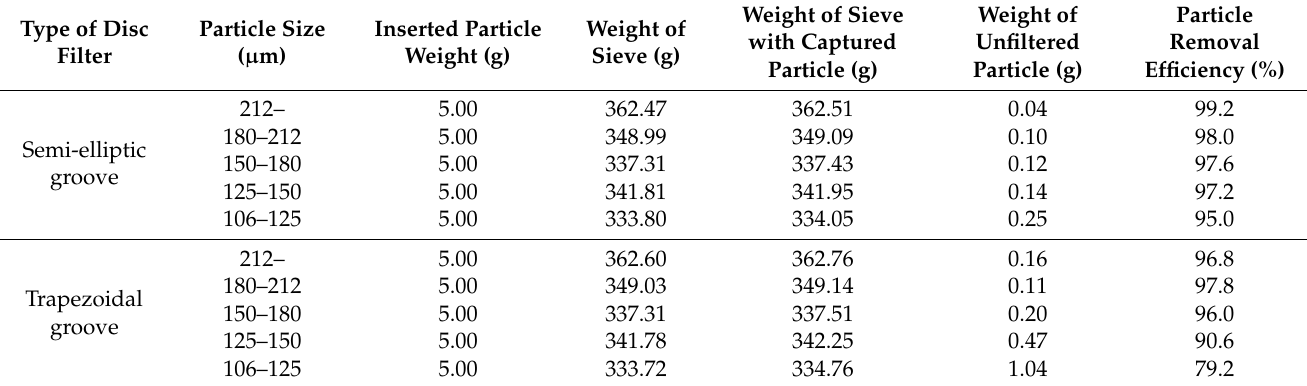
Table 5. Filtration performance test to evaluate the particle removal efficiency of the disc filters. Type of